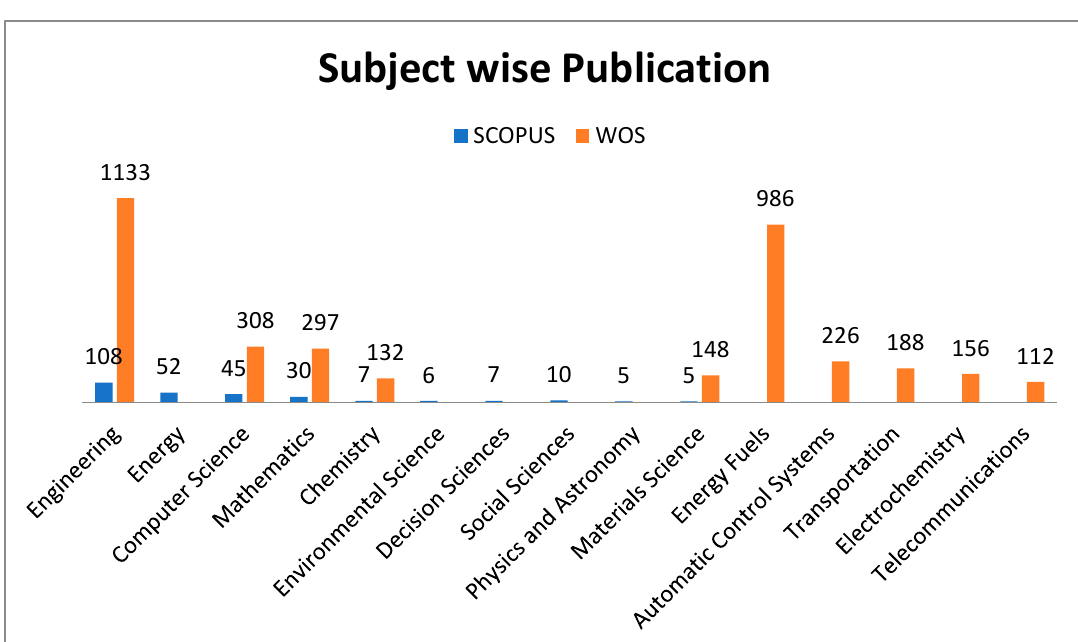
Figure 10. Subject-wise number of publications in SCOPUS DB and WOS DB.